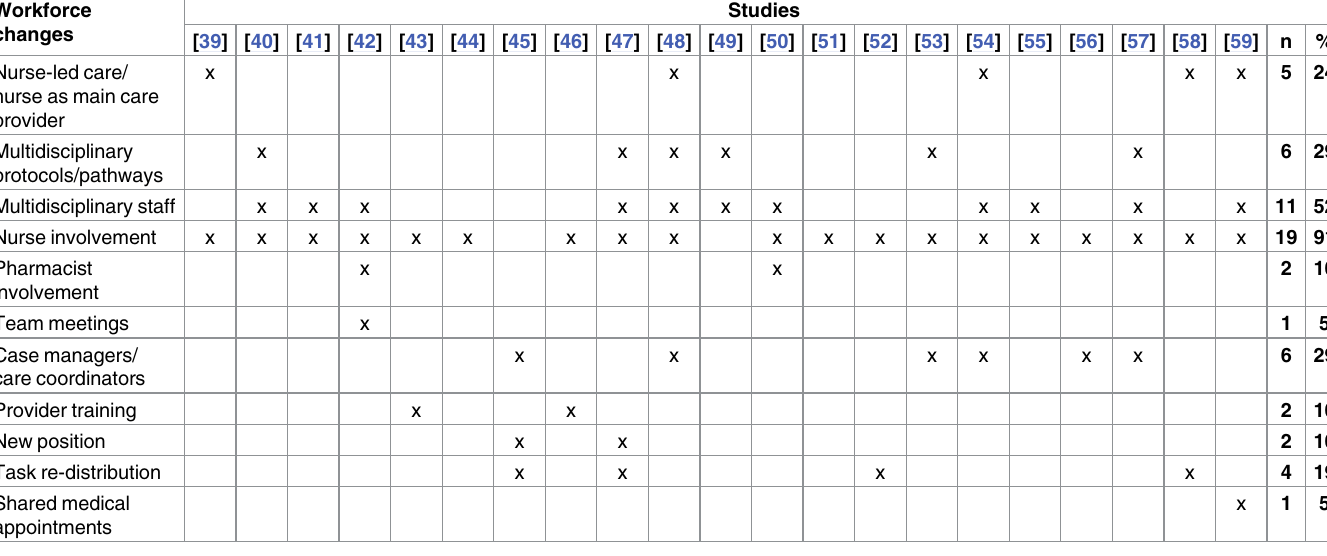
Table 3. Overview of workforce changes per included study and number and percentage of studies mentioning the respective